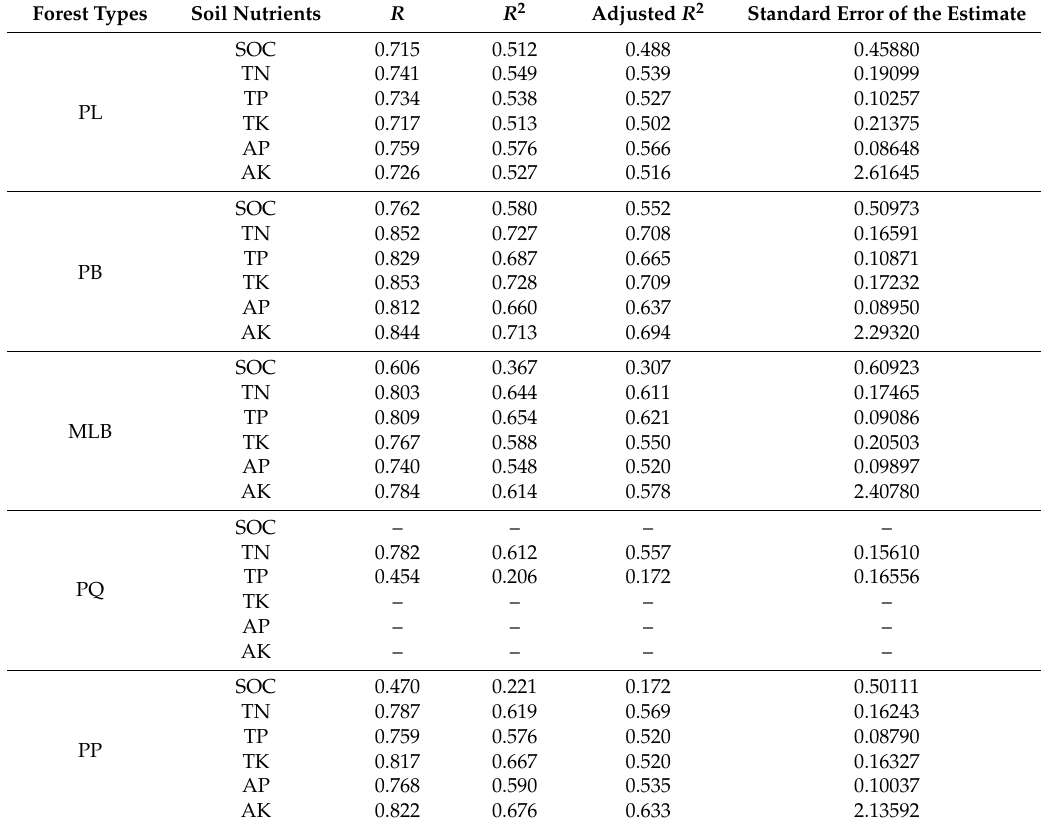
Table 4. Step regressions between soil nutrients and climatic factors in the five main forest types. Forest Types Soil Nutrients